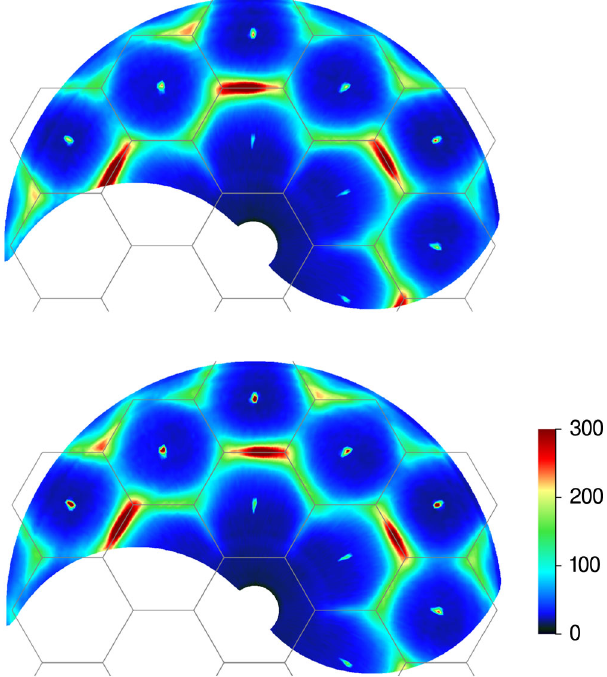
FIG. 3. Diffuse magnetic scattering of the YBaCo 3 FeO 7 single crystal T ¼ 4 K, in the ( hk 0 ) scattering plane. Top: I , spin-flip x 0 ¯ x 0 scattering with P k X 0 ; bottom: I ¯ , polarization reversal P k − X 0 . x 0 x 0 Note the deviation from the mirror symmetry. This antisymmetric part reverses with the direction of P and is a direct sign of the underlying cycloidal chirality. (Intensities are given in neutron counts/s, while measuring all points for 25 s. Number of FIG. 4. Top: normalized observed chiral scattering S yz Q . Bottom: independent data points is 8640. The hexagonal Brillouin zone modeled chiral scattering based on cycloidal chiral correlations of the nuclear unit cell is shown in gray.) obtained by Fourier